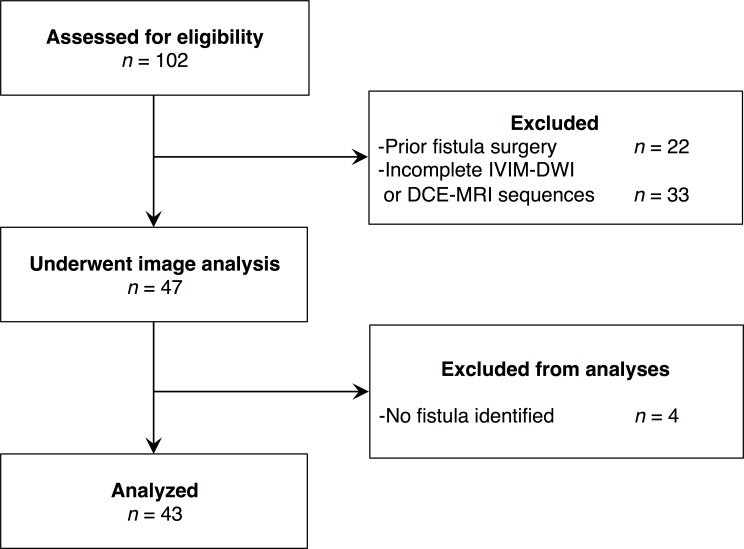
Study flowchart.